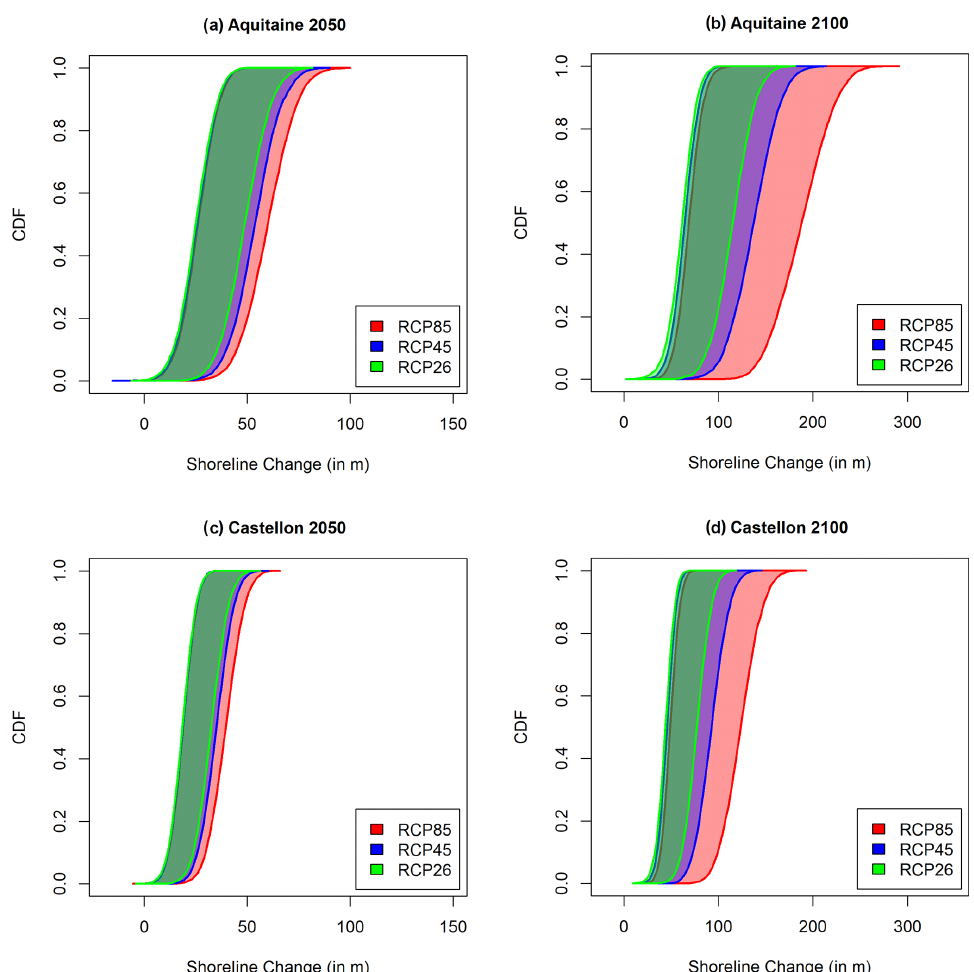
Figure 6. Projected shoreline change probability boxes in (a, c) 2050 and (b, d) 2100 for (a, b) site 1 in Aquitaine and (c, d) site 2 in Castellón. Projections are shown for the (green) RCP2.6, (blue) RCP4.5 and (red) RCP8.5 scenarios. Ambiguity and low- and high-end corresponding values are given in Table